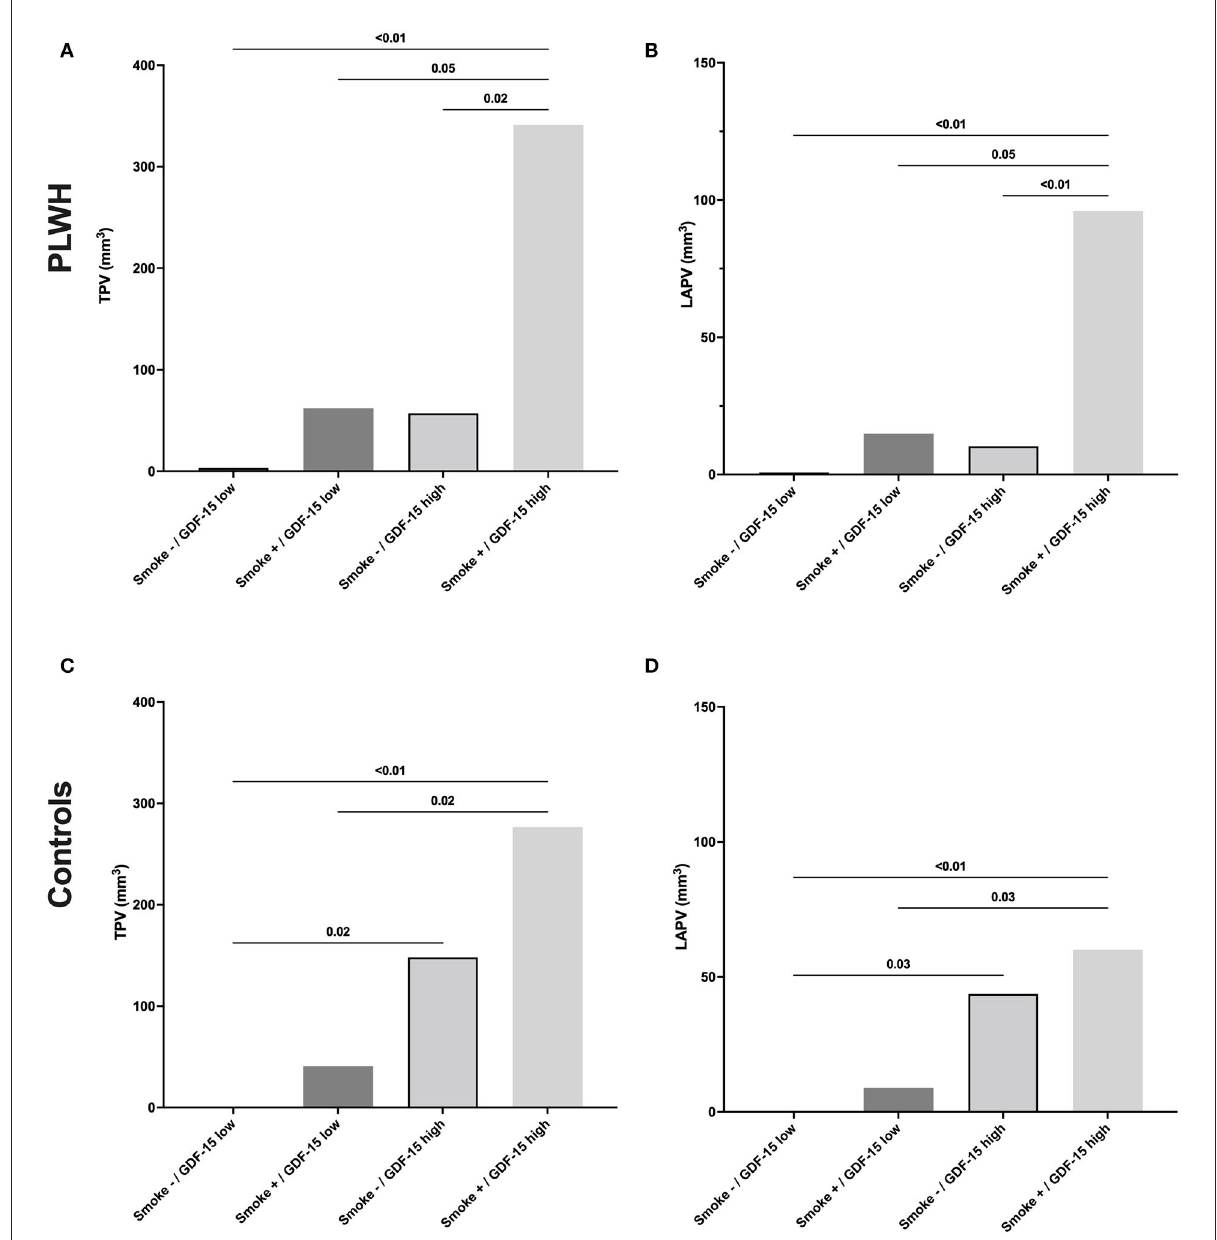
FIGURE2 Total or low-attenuation plaque volume depending on the smoking status and GDF-15 level in PLWH and controls. GDF-15 levels below the median value of our participants (766 pg/ml) were defined as “low,” whereas levels above this value were defined as “high.” PLWH, people living with human immunodeficiency virus; TPV, total plaque volume; LAPV, low-attenuation plaque